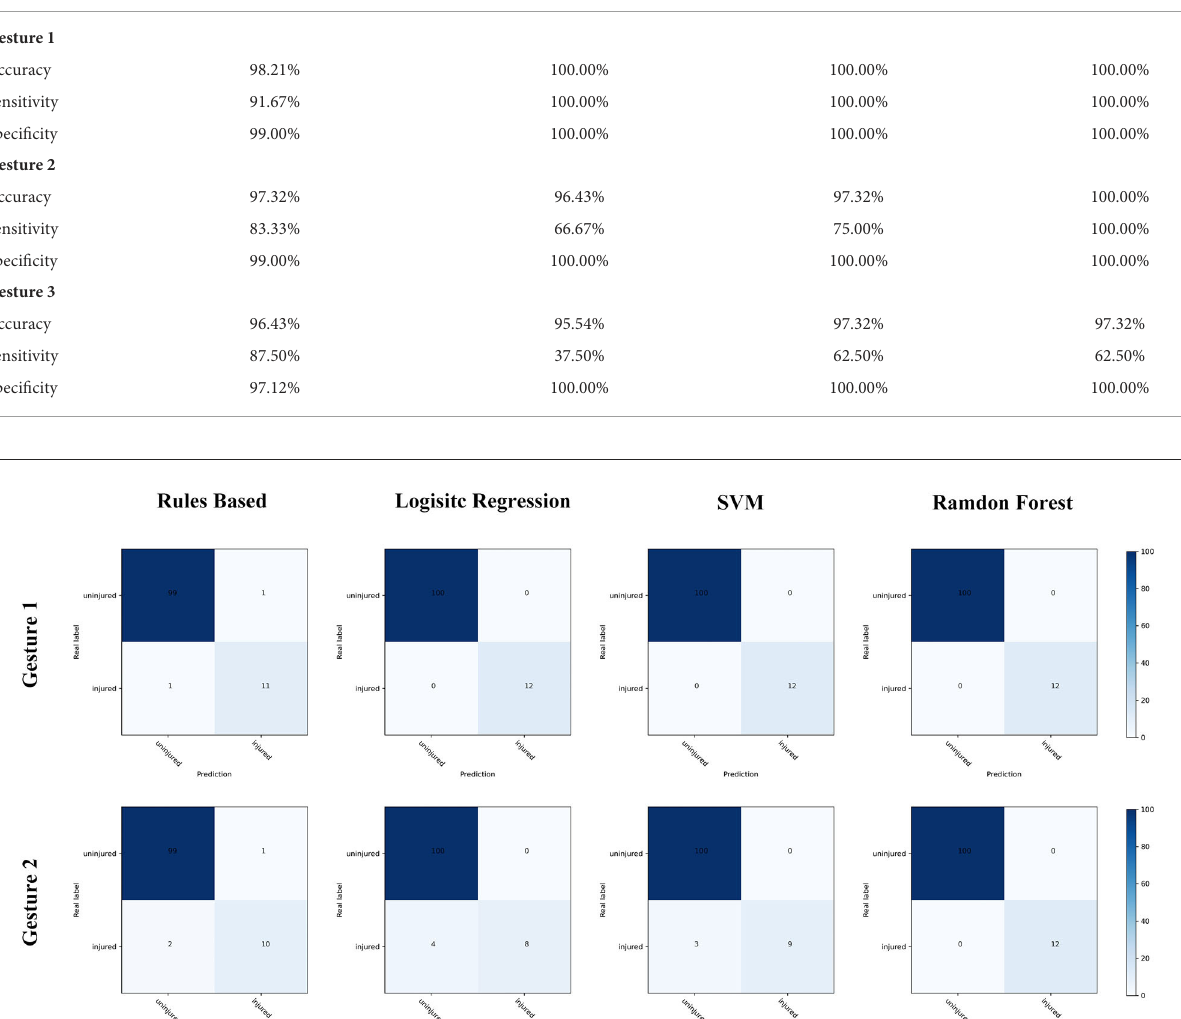
Leap Motion was not favorable with manual measurement (